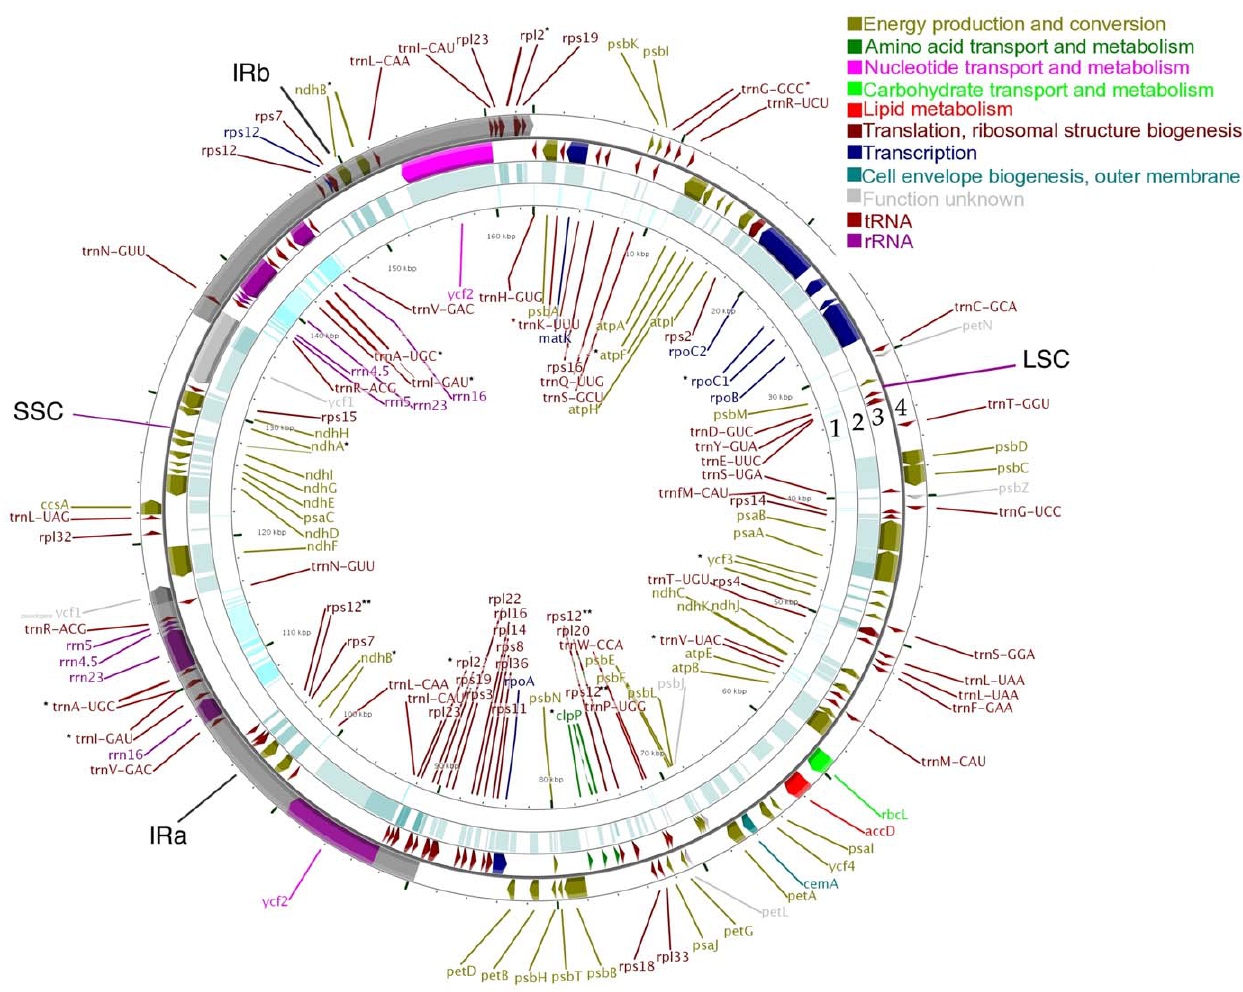
Figure 1. Map of the castor bean chloroplast. The large (LSC, 89,652 bp) and small (SSC, 18,817 bp) single copy regions are separated by two inverted repeats (IRa and IRb, 27,347 bp each), which are colored in grey. The outer most whorl (4) contains genes transcribed clockwise, and the genes on whorl 3 are transcribed counter-clockwise. The inner-most whorl (1) shows the alignment of a nucleotide blast of R. communis against all cassava ( M. esculenta ) tRNAs and rRNAs from the plastid genome. Whorl 2 shows the alignment of a nucleotide to protein blast (BLASTX) of R. communis against all proteins of the cassava plastid genome ( M. esculenta ). * Split genes or genes with introns. ** Trans-spliced gene rps12 .